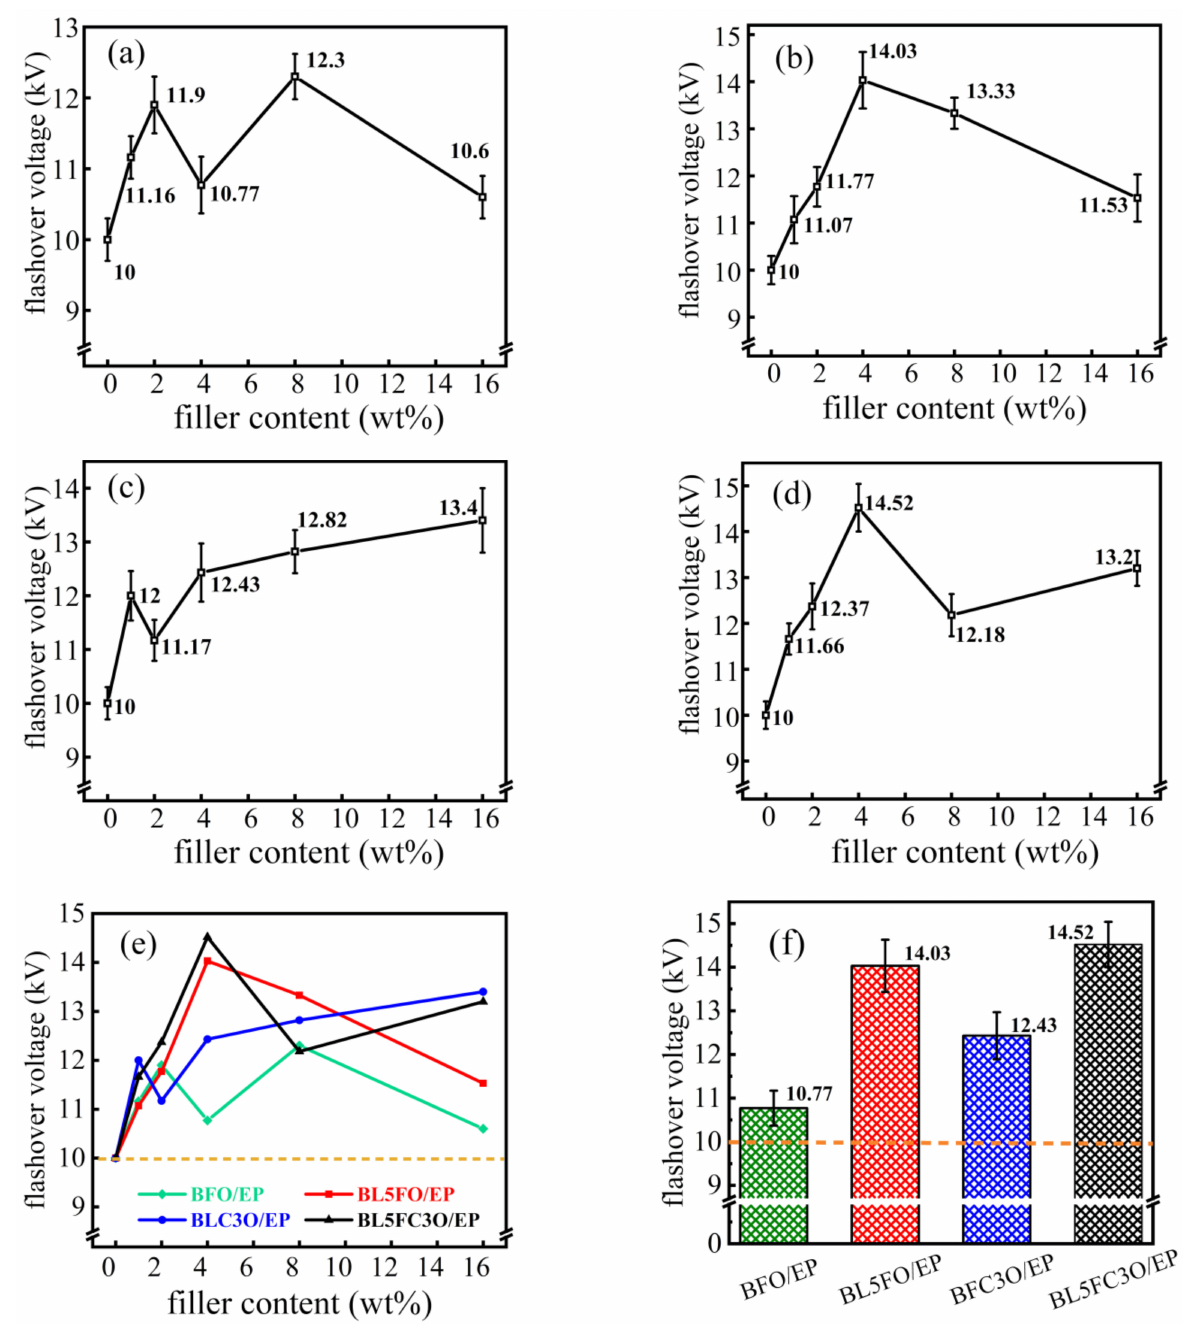
Figure 7. Flashover voltage diagram of element-doped BFO/EP composites with different filler mass fractions. ( a ) BFO/EP; ( b ) BL5FO/EP; ( c ) BFC3O/EP; ( d ) BL5FC3O/EP; ( e ) summary chart; ( f ) the flashover voltage when the composite filler is doped with a mass fraction of 4